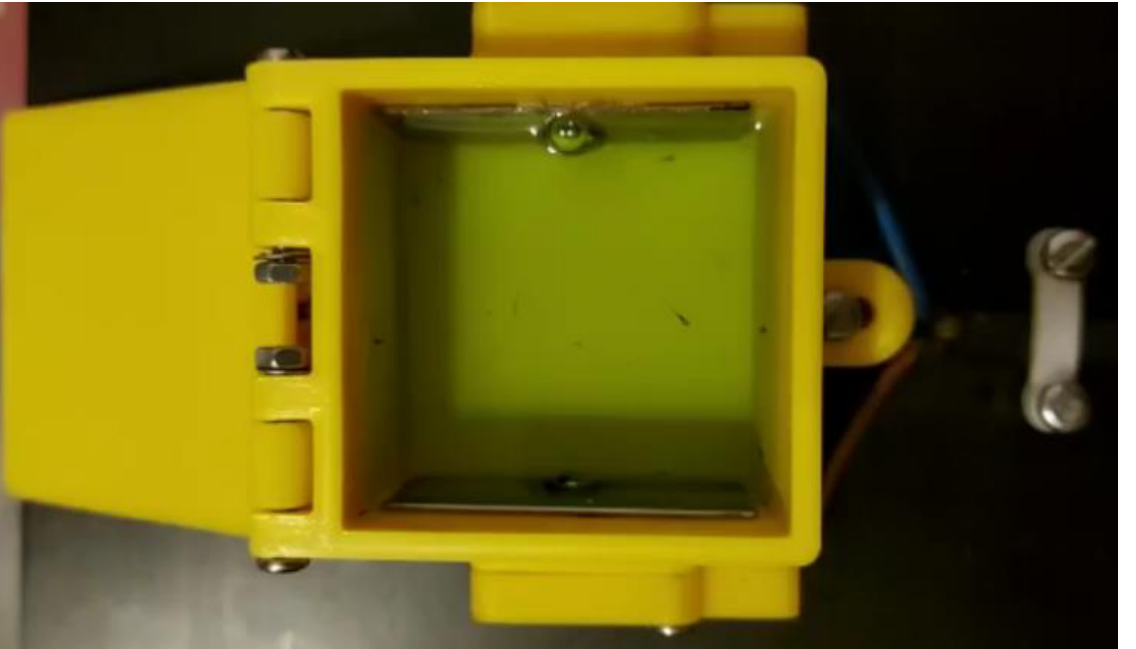
Figure 1. EFS-Wasp1 (Fish Management Systems Ltd., Carrickfergus, U.K.) chamber for electrical stunning with larvae ( Danio rerio ) in embryo media.